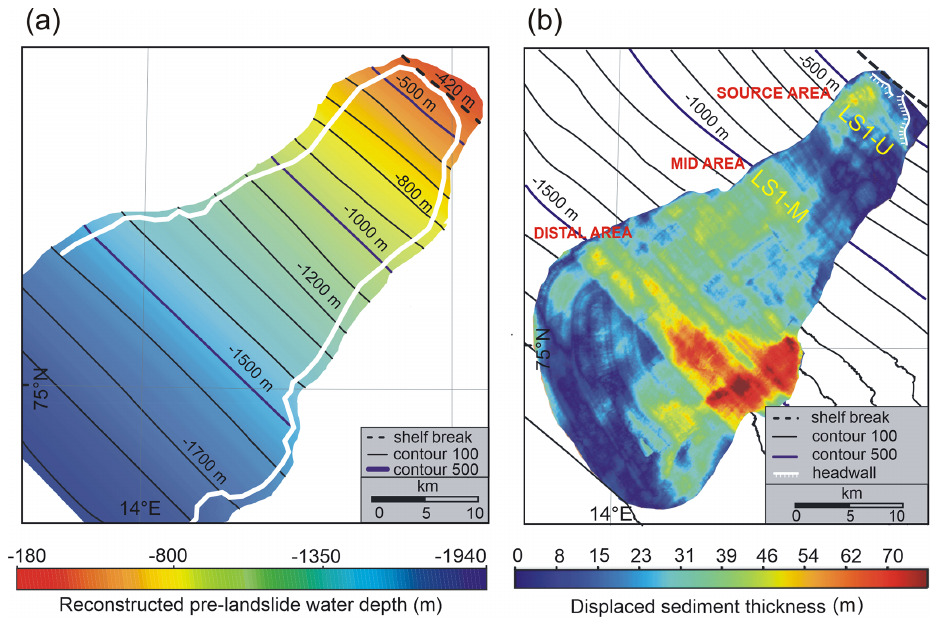
Figure 4. The Storfjorden LS-1 landslide geometry. (a) Reconstruction of pre-landslide seafloor morphology. (b) Available displaced sedi- ment thickness in metres. Note the location of the different sliding upper and middle sectors (LS1-U and LS1-M, respectively).